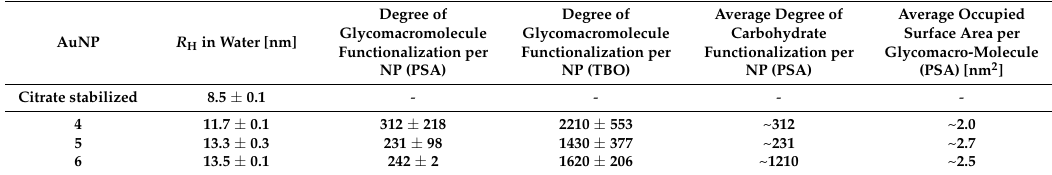
Table 1. The DLS derived hydrodynamic radii ( R H ) and degree of glycomacromolecule functionalization determined by phenol sulphuric acid method (PSA) and Toluidine Blue O-Titration (TBO) and derived average degree of carbohydrate functionalization and occupied surface area. Degree of AuNP R H in Water [nm]